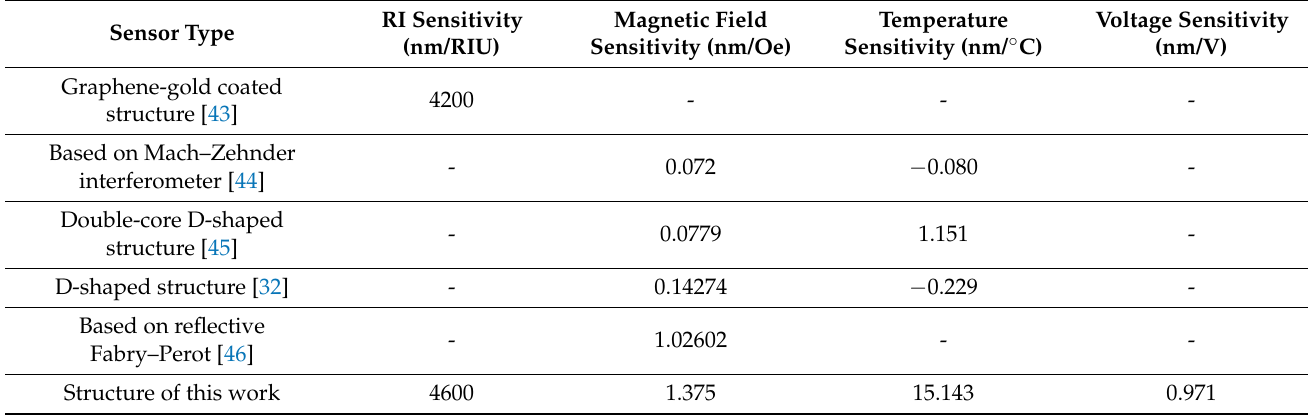
Table 3. Performance comparison of different